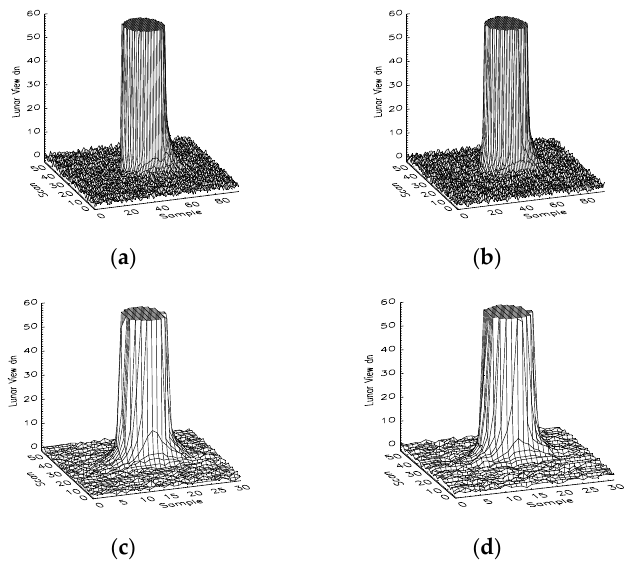
Figure 4. Lunar images observed by SNPP VIIRS thermal emissive bands M13 and M16 on 2 April 2012: ( a ) Band M13 Detector 8; ( b ) Band M13 Detector 9; ( c ) Band M16 Detector 8; and ( d ) Band M16 Detector 9.